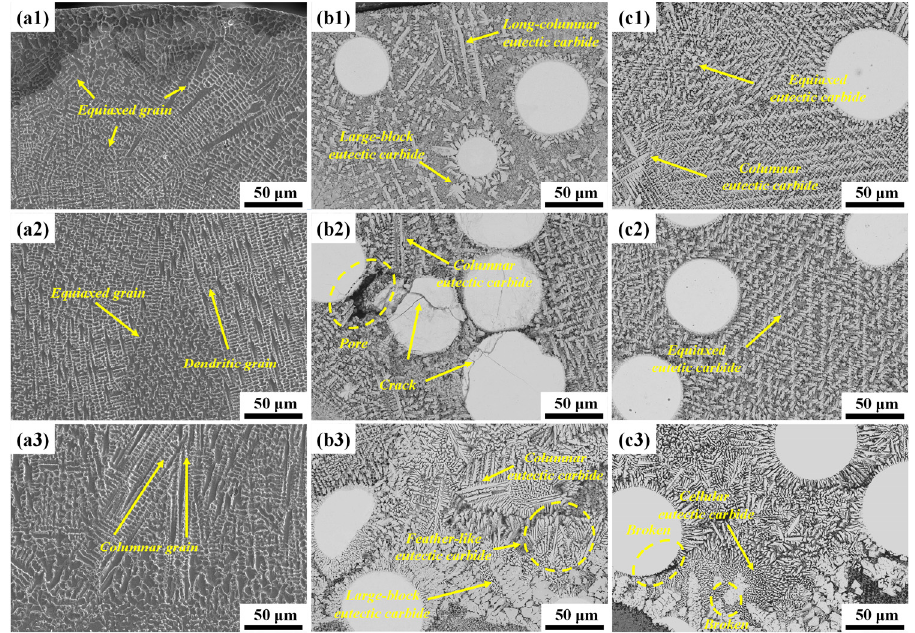
Figure 6. Typical microstructure on cross-section. ( a1 – a3 ), ( b1 – b3 ) and ( c1 – c3 ) are the cross-sectional morphologies of Coating A, Coating B and Coating C, respectively. 1, 2 and 3 represent the top region, middle region and bottom region, respectively.